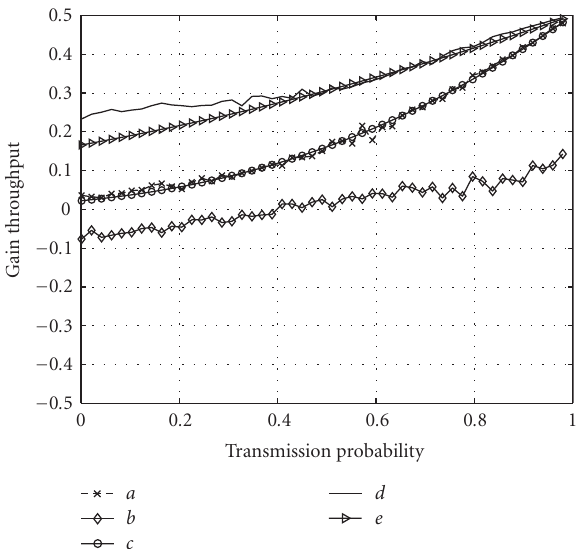
Figure 19: Stability region y i of the dynamic ( K (cid:5) = 3) and static ( K (cid:5) = 0) cases for K = 4 (asymmetric network of Figure 11).